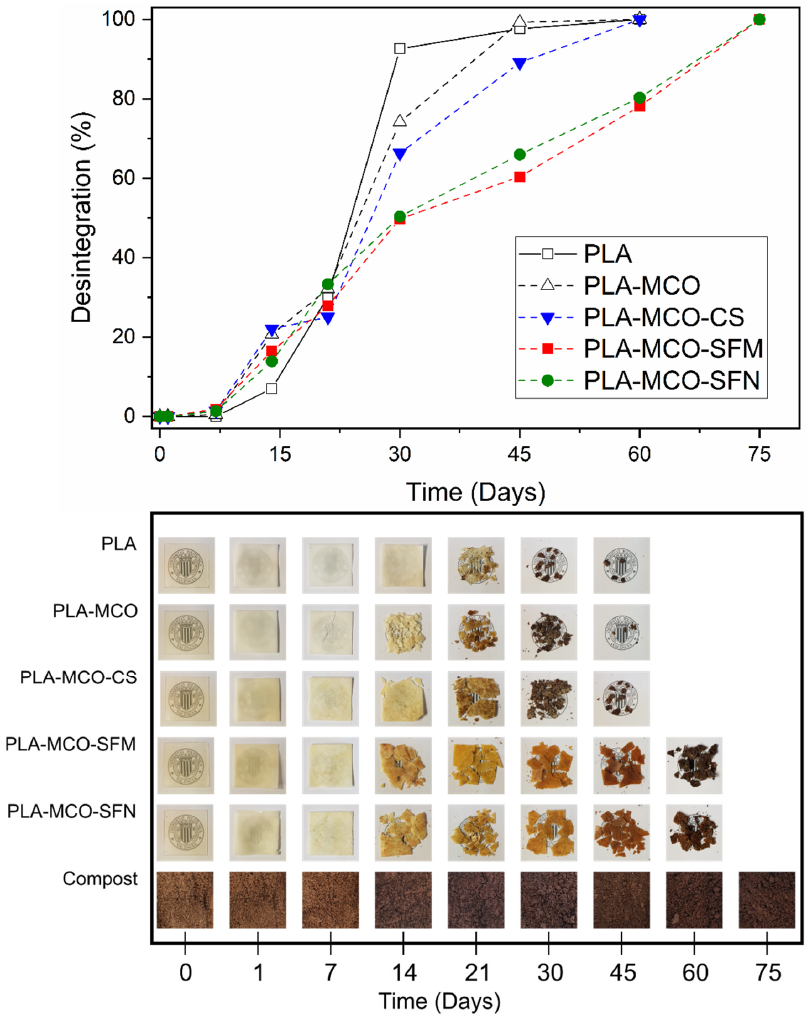
Figure 9. Photographic registry of the Disintegration of PLA and different PLA-composites, containing MCO and silk fillers, under controlled composting conditions.